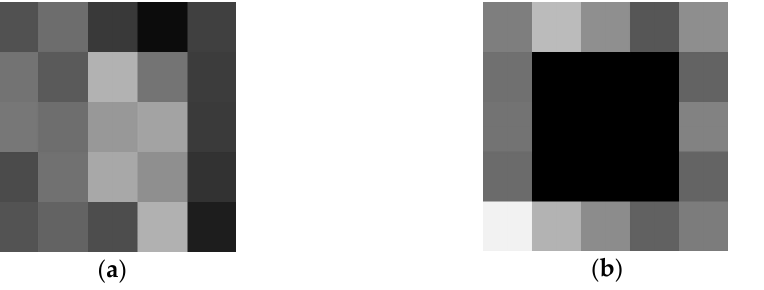
Figure 4. The output of the 4th layer feature map of CNN PRYSTINE before max pooling, ( a ) without masking, ( b ) with masking of the central region of 3x3 around the centroid.